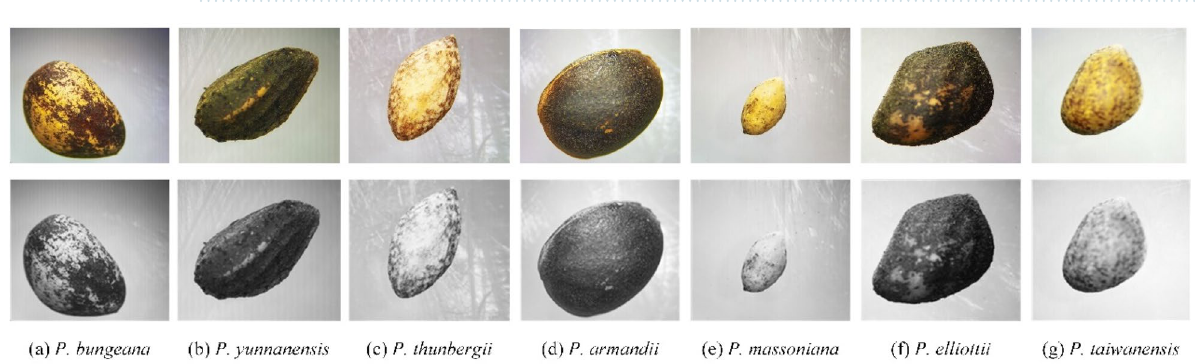
Figure 6. Sobel edge detection and clipping process.